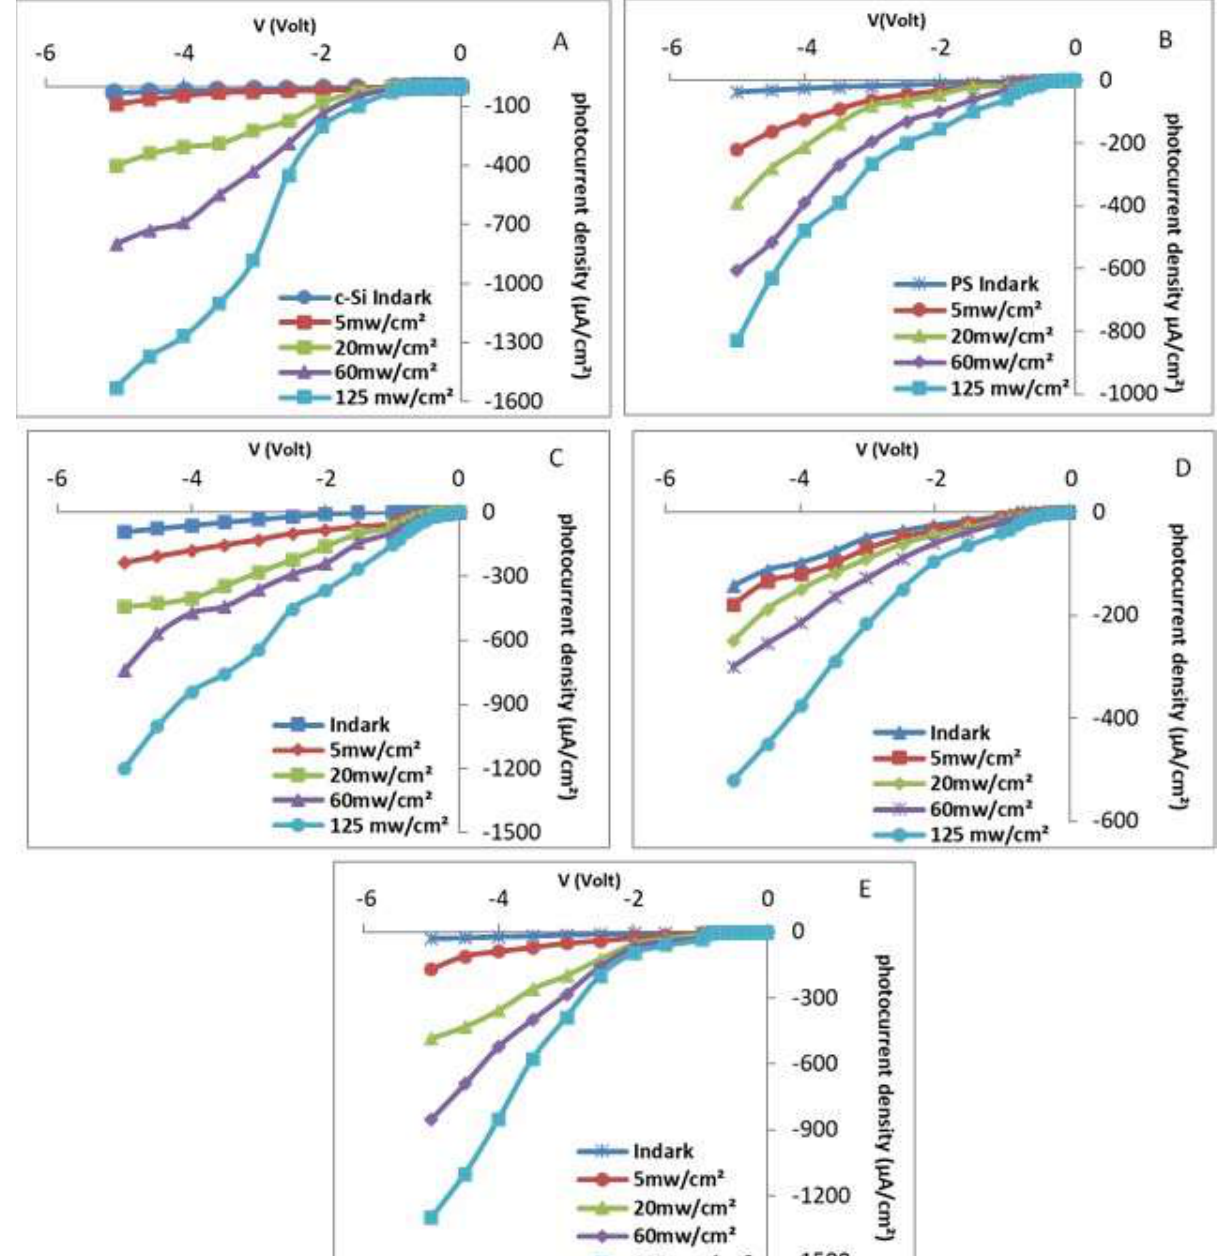
Figure 5: The I ph –V behavior of the applied reverse voltage of (A) c-Si (B) PS etched at 12mA/cm 2 current density with 16% HF concentration for 15min., Al/Au:TiO 2 NPs/PS/n-Si/Al with different laser energy (C) 600 mJ, (D) 800 mJ and (E) 1000